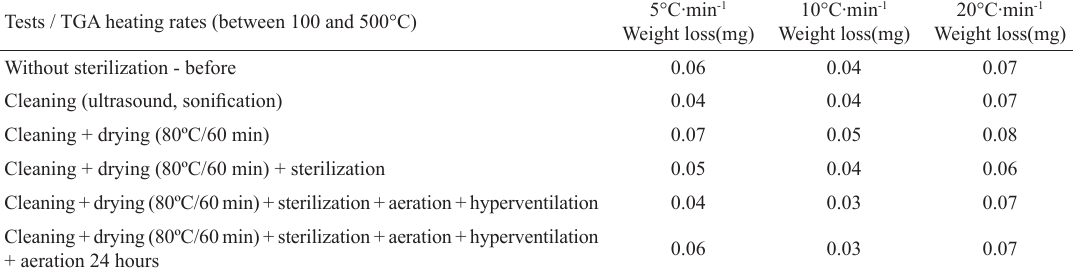
Table 3: Weight loss in mg, for PEEKc and PEEKm by TGA after machining, hygienization and sterilization process stages at different TGA heating rates. Tests / TGA heating rates (between 100 and